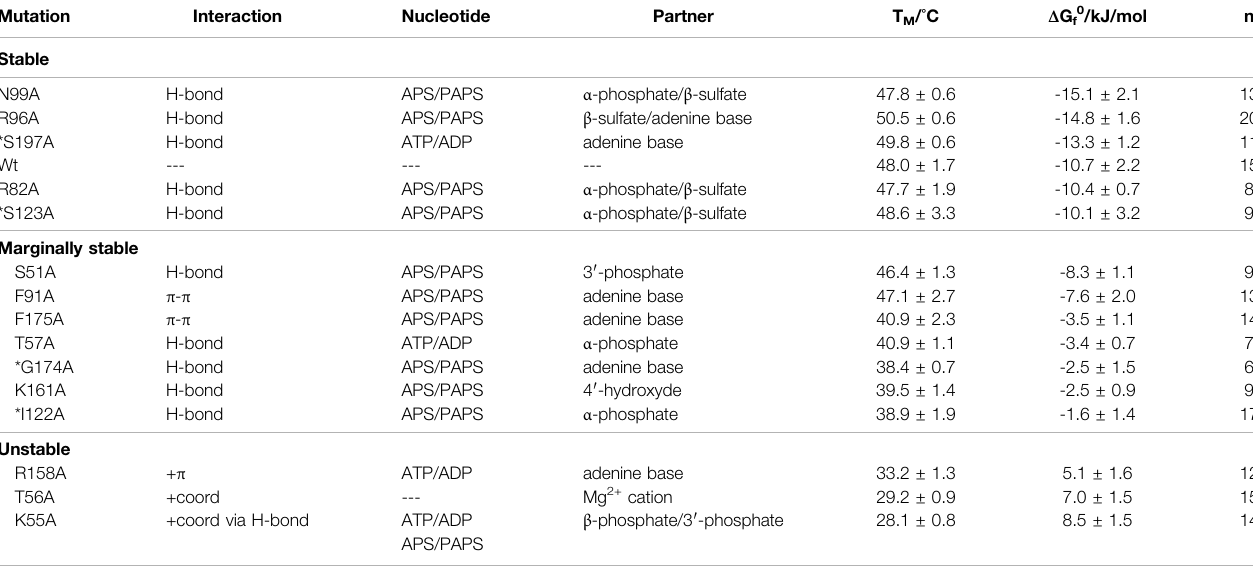
TABLE 1 | Summary of APSK37 in-cell binding-site analysis. Mutations are split into stable, marginally stable and unstable variants and sorted according to their Δ G f0 . Δ G f0 corresponds to the standard free energy of folding at 37 ° C. Asterisks depict mutations originally interacting with the nucleotide via their peptide backbone. Values are depicted as mean ±